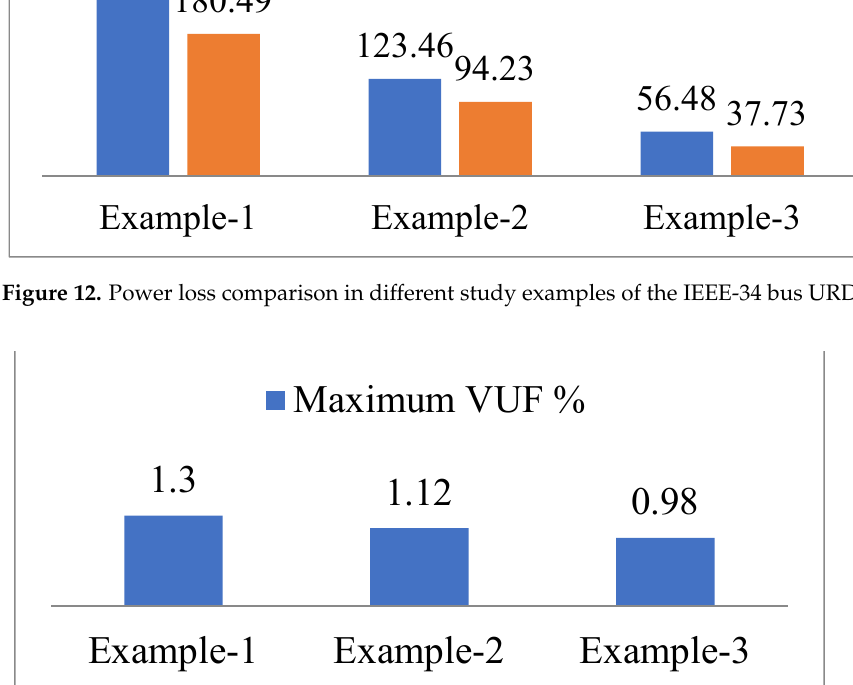
Figure 13. Maximum VUF% in different study examples of the IEEE-34 bus URDN.